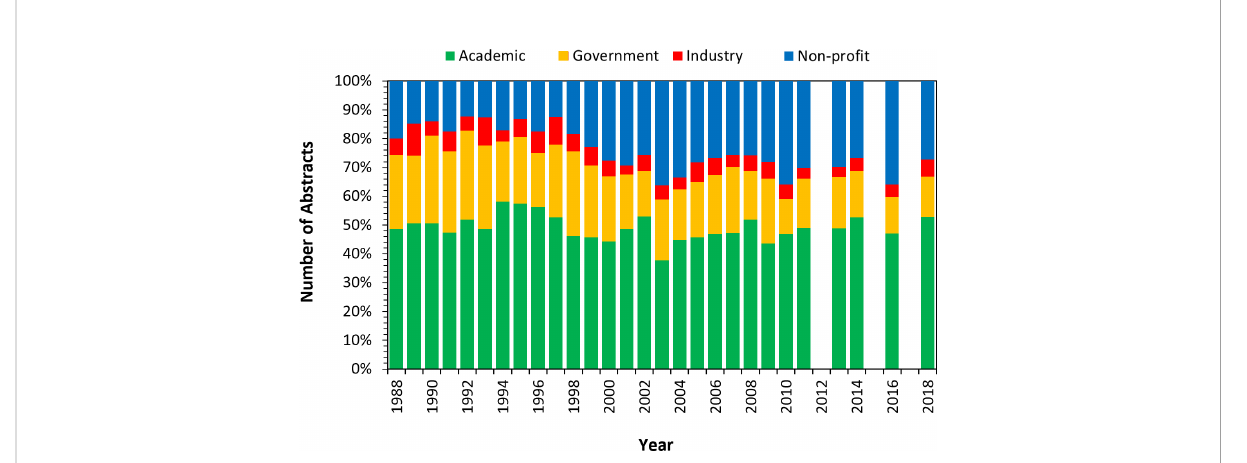
FIGURE 8 Institutional af fi liations of the fi rst authors on abstracts from the International Sea Turtle